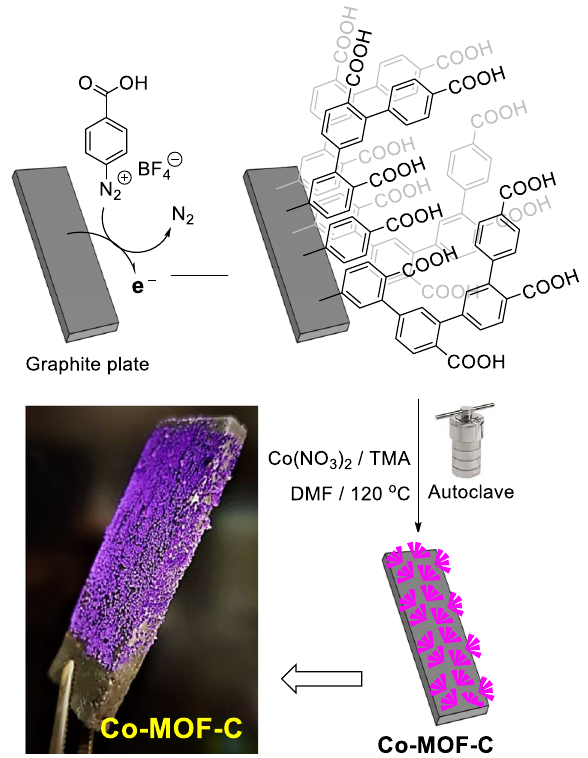
Figure 6. Schematic illustration of graphite electrode modification